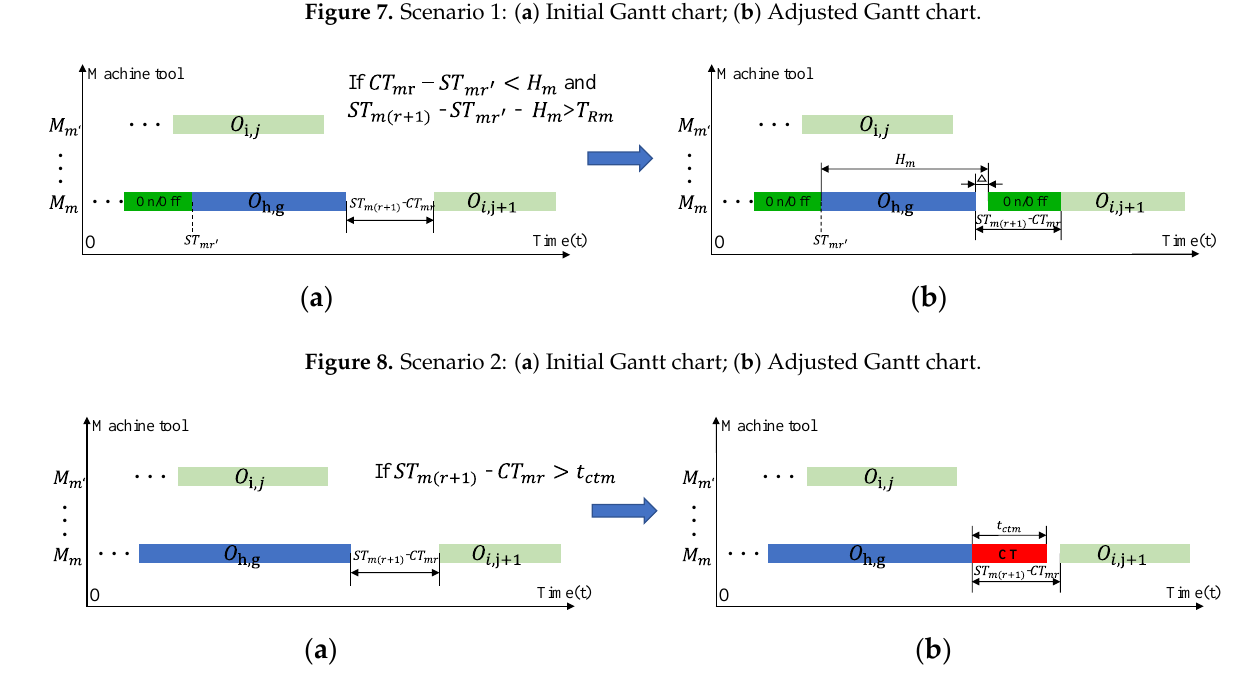
Figure 9. Scenario 3: ( a ) Initial Gantt chart; ( b ) Adjusted Gantt chart.